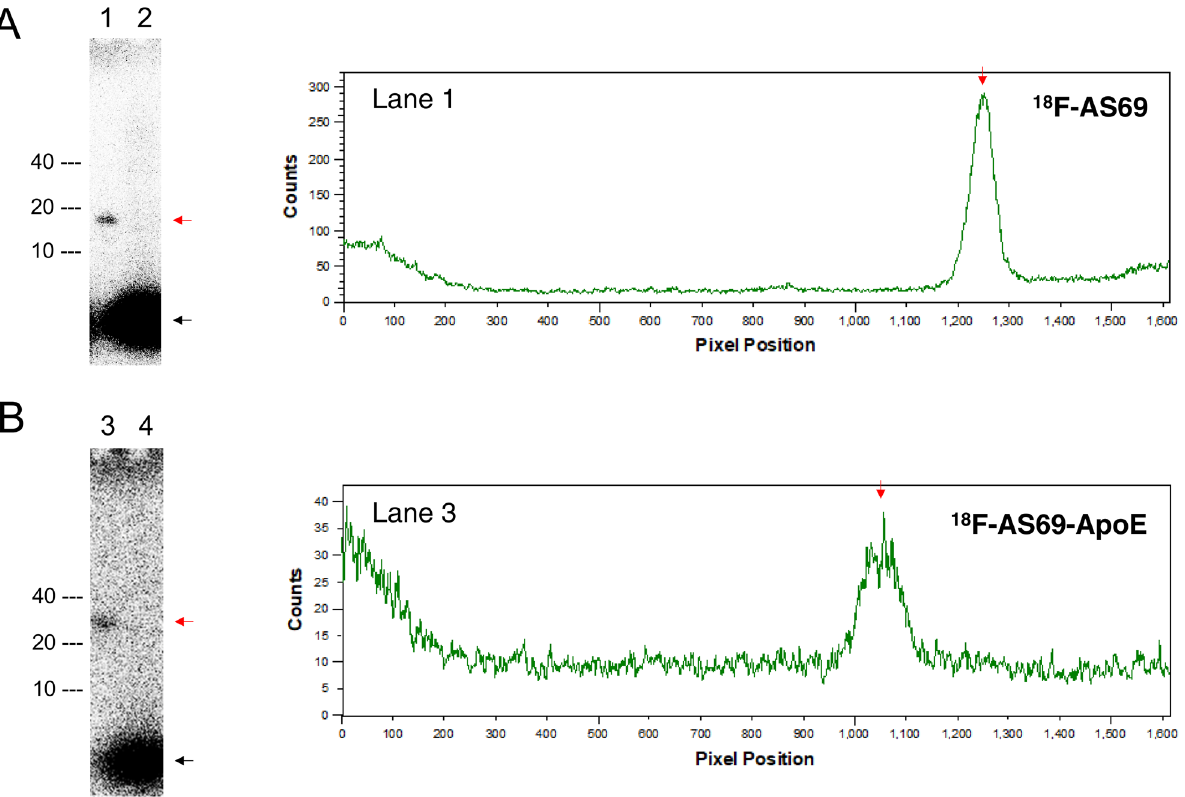
Figure 6. In vivo stability of 18 F-AS69 and 18 F-AS69-ApoE in mice. Results for 18 F-AS69 (A, 14 kDa) and 18 F-AS69-ApoE (B, 22 kDa). The figure presents autoradiographs from gels following SDS-PAGE analysis of mouse urine or blood samples collected as described in the experimental section. Blood (lane 1 and 3) or urine (lane 2 and 4) samples of mice collected 30 min after injection of 18 F-AS69 (lane 1 and 2) or 18 F-AS69-ApoE (lane 3 and 4) were tested. Black arrows indicate signals from mouse urine samples. Full-length autographic images and gels were shown in Fig.